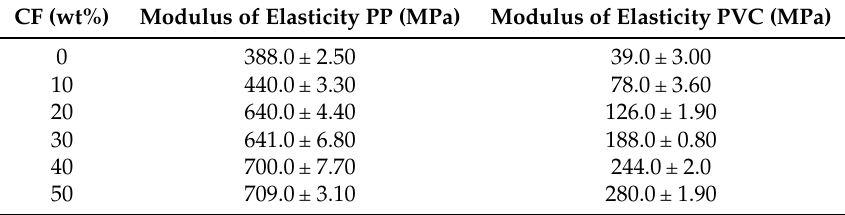
Table 5. Modulus of elasticity for PP and PVC set with different filler content, CF.